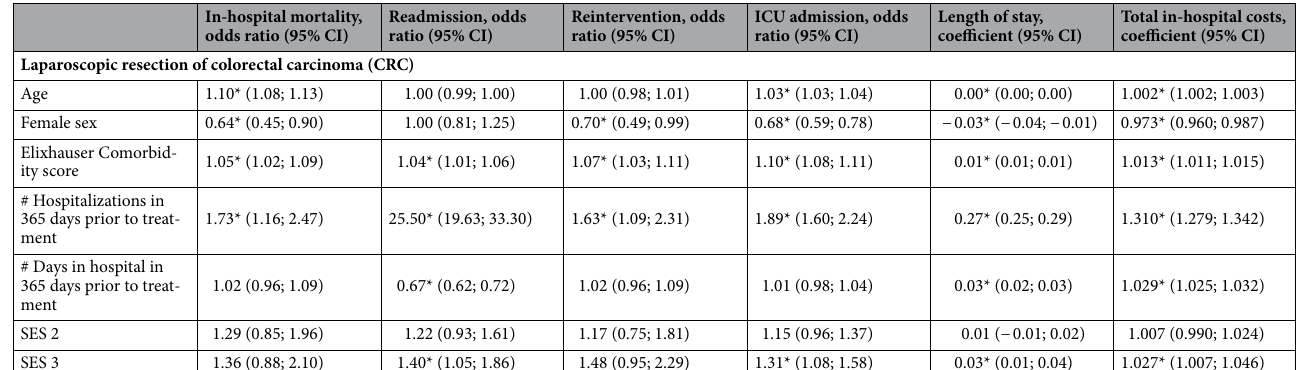
Table 3. Prognostic factors for outcomes and costs for colorectal carcinoma, where * p ≤ 0.05.